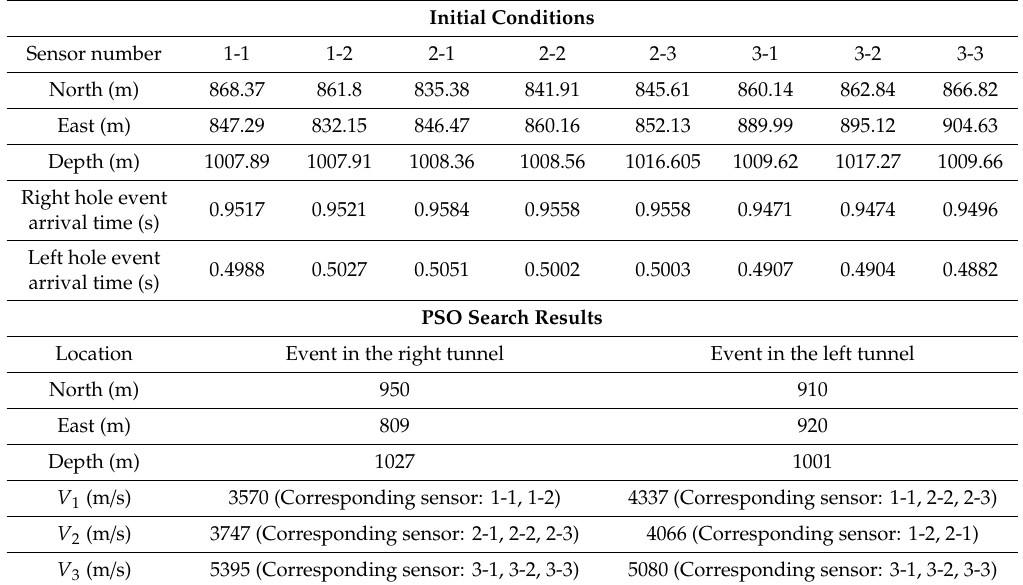
Table 2. Particle swarm optimization (PSO)-based source location method, including initial conditions setting and search